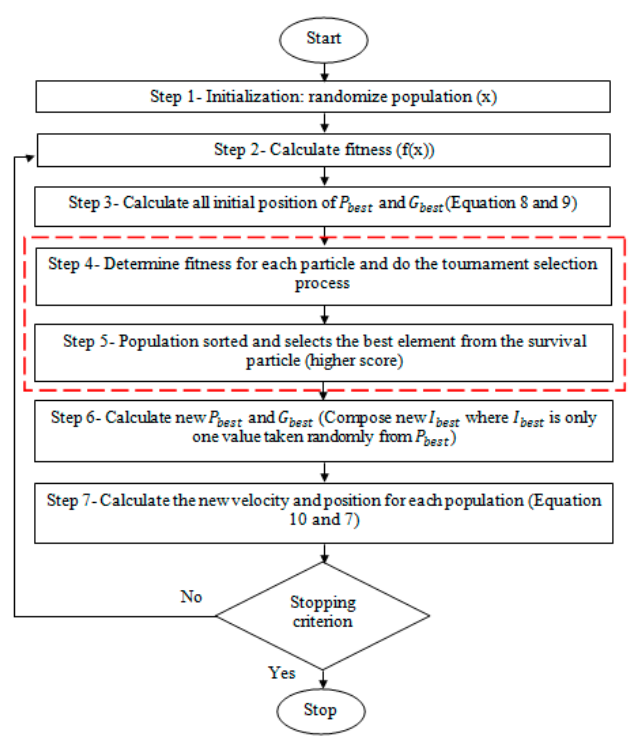
Figure 2. Improved evolutionary particle swarm optimization (IEPSO) algorithm flowchart.